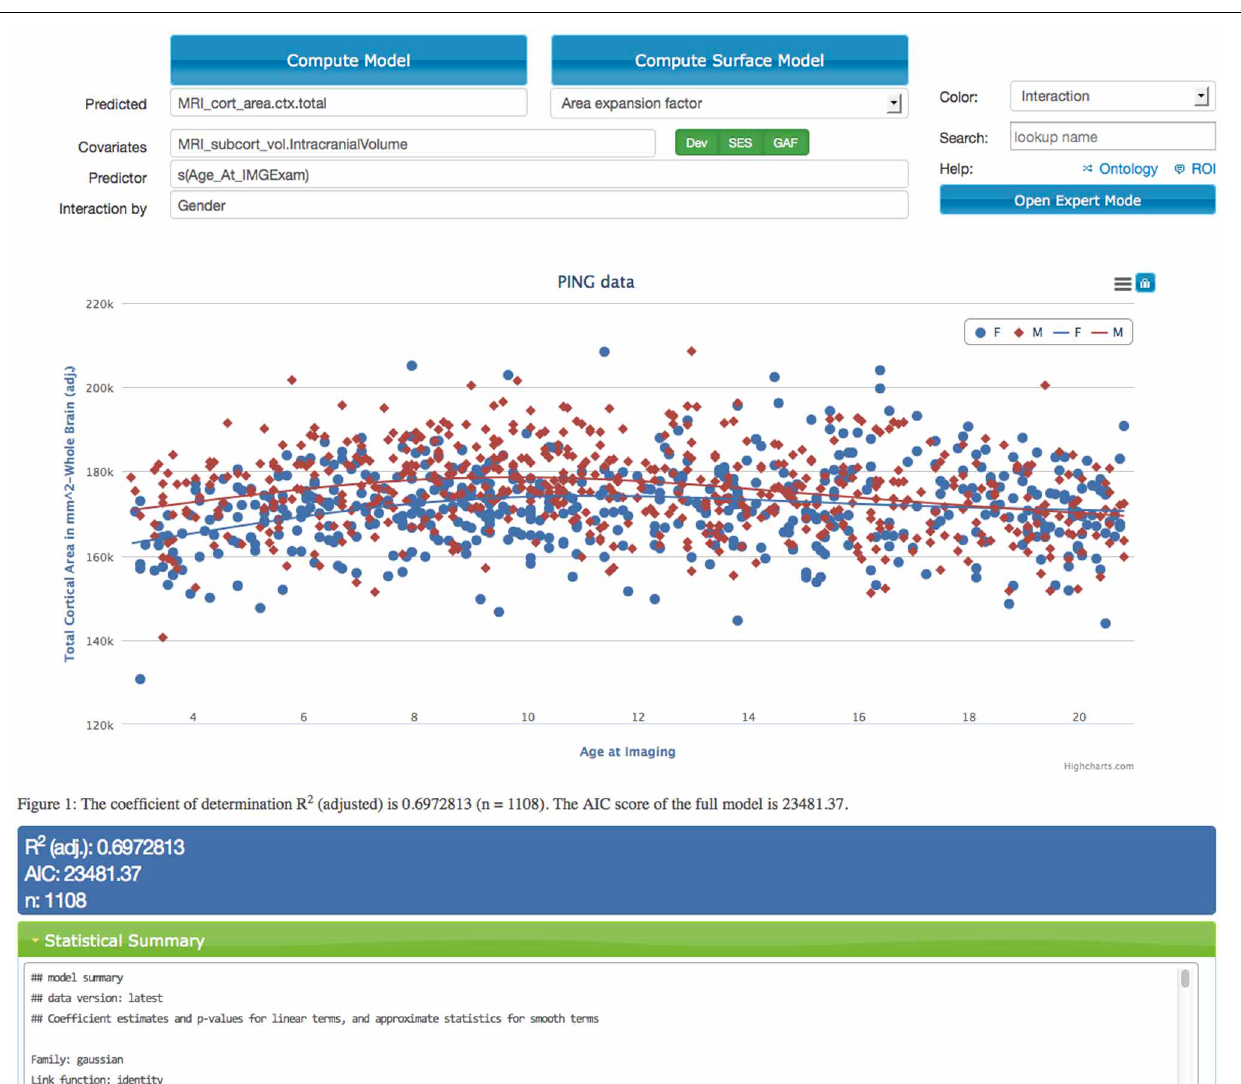
FIGURE 2 | Screen capture of the data exploration application displaying a statistical analysis of the effects of age on the total cortical area for male (red dots and curve) and female (blue dots and curve) children in the PING study. The model corrects for the effects of intra-cranial volume, scanning device, socio-economic factors, and genetic ancestry. Interface components that relate to model specification are